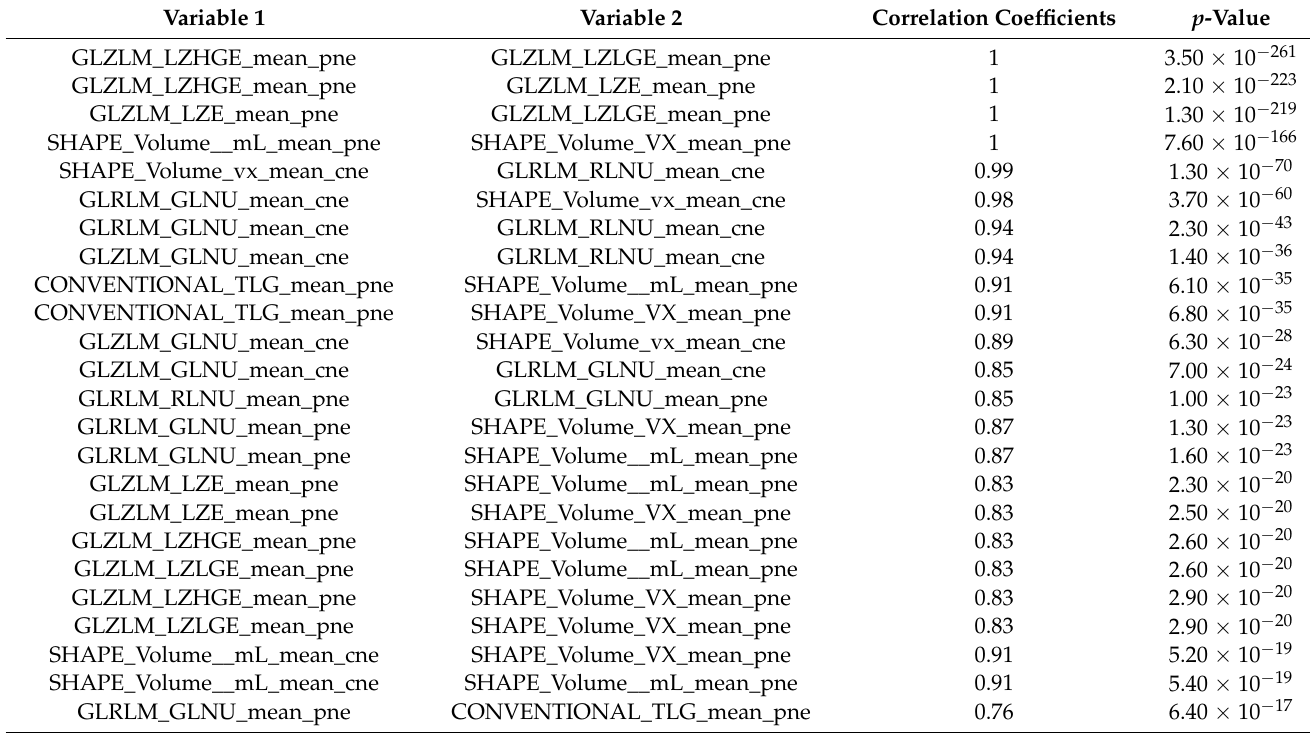
Table 6. Bivariate correlation coefficients between variables. ( p -value < 0.001 for all the below listed bivariate